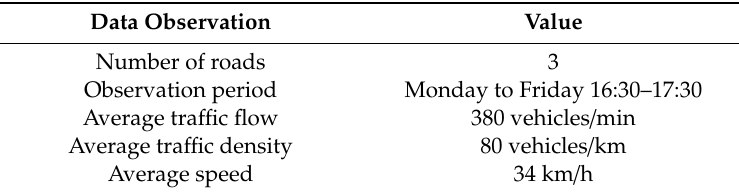
Table 3. Actual observed tra ffi c data.